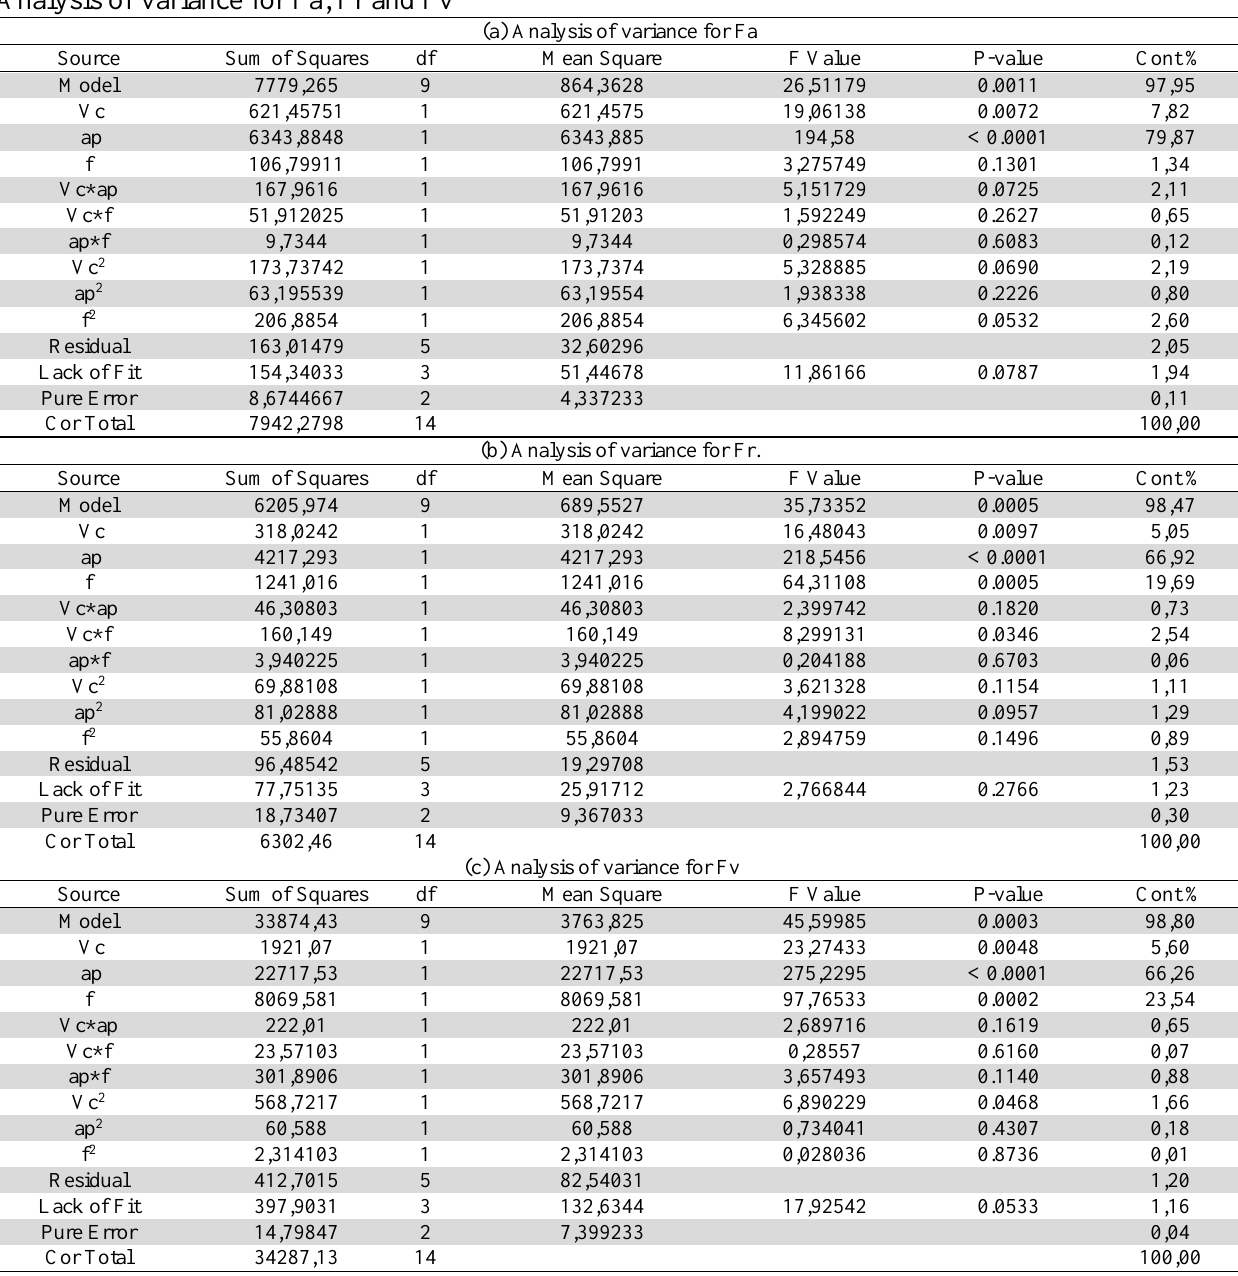
(a) Analysis of variance for Fa